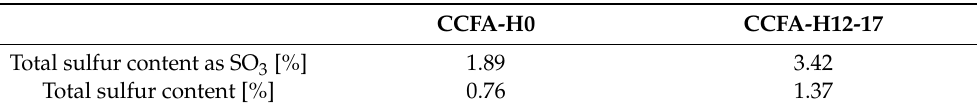
Table 9. The chemical analysis of the fired bodies—sulfur content depending on water glass content in raw materials mixture (0% vs.